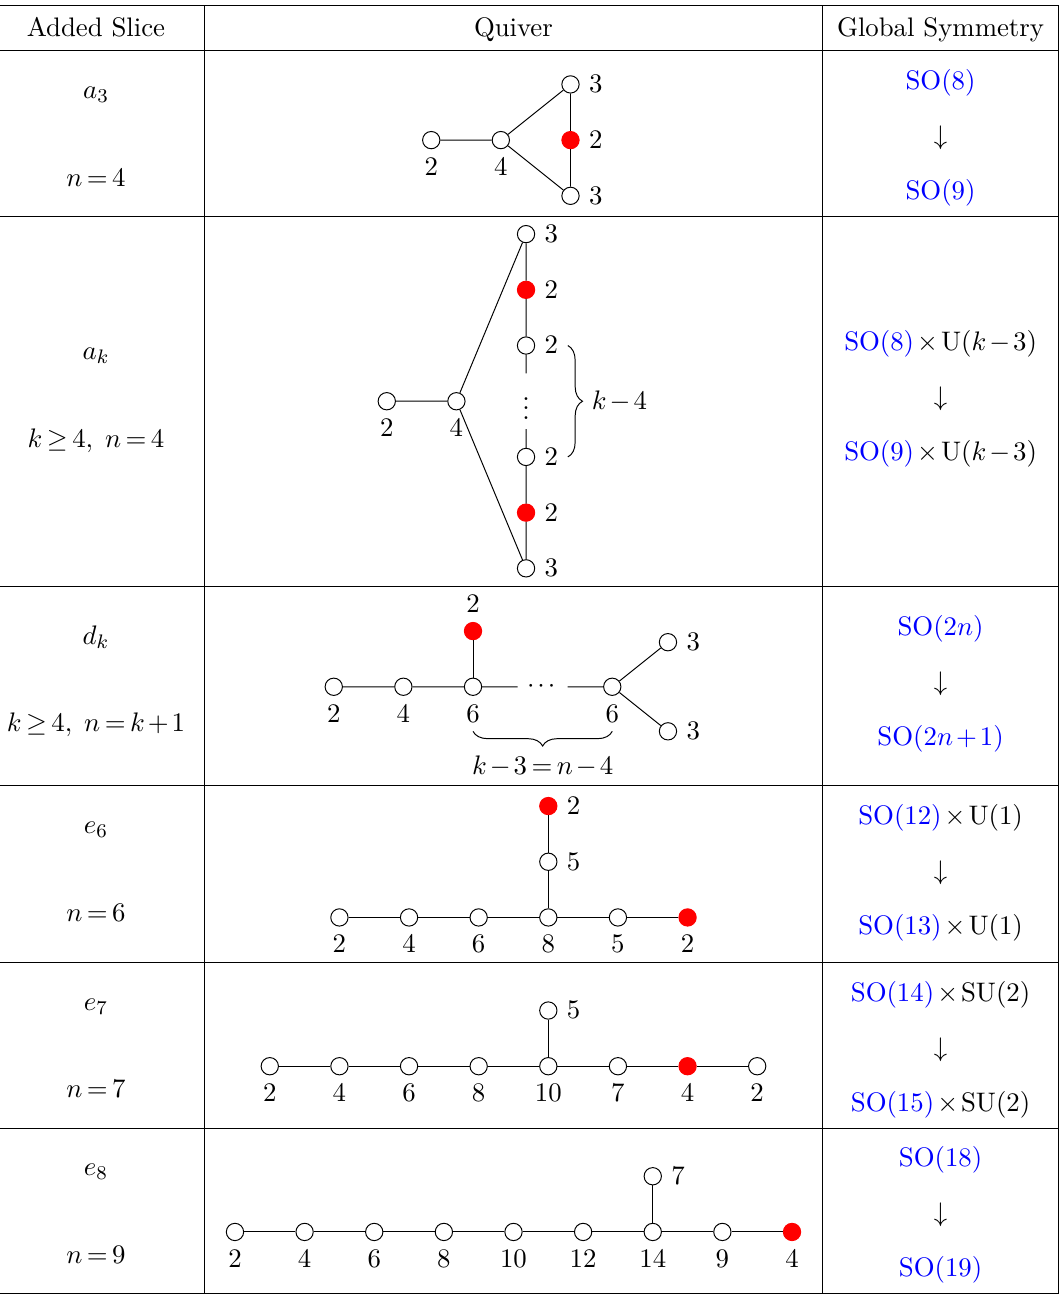
Table 4 . Quivers resulting from adding all possible elementary slices to the existing nodes of n.min B n (4.1) to absorb a , n ≥ 4